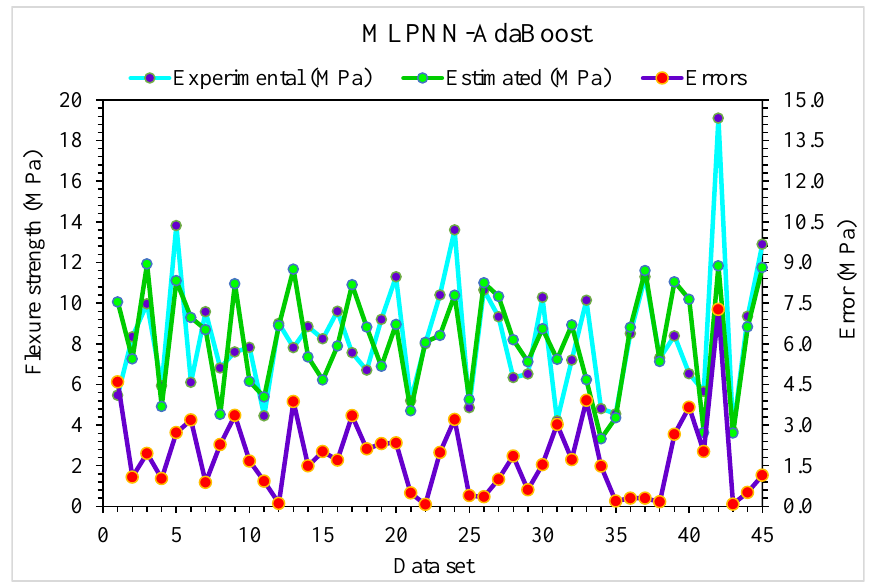
Figure 15. Distribution of experimental and MLPNN-Bagging predicted values with errors for flex- ural strength.